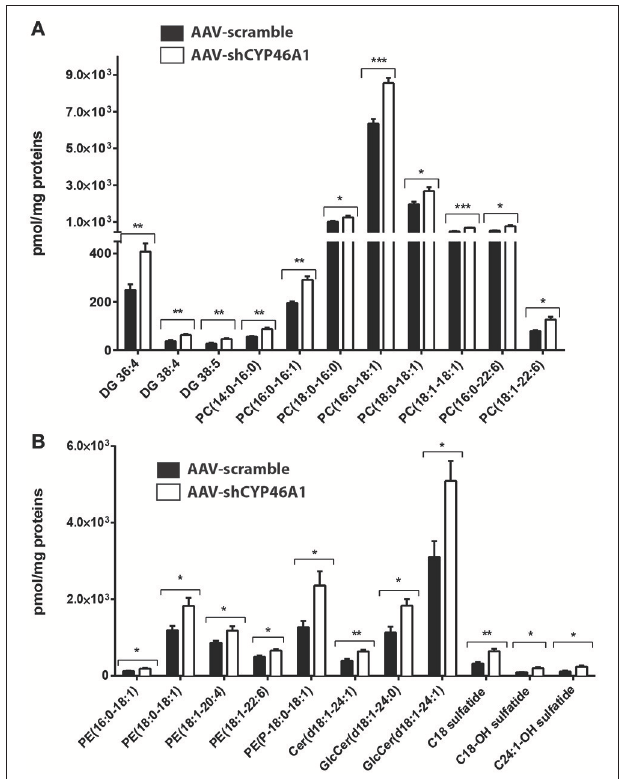
FIGURE 3 | Relative quantification of lipids in hippocampus of C57Bl/6 mice after injection of AA V5-scramble (control) and AA V5-shCYP46A1. (A,B) Rise of phosphatidylcholine (PC), diacylglycerol (DAG), ceramides (Cer), sulfatide, phosphatidylethanolamine plasmalogen (PE-P) and phosphatidylethanolamine (PE) in AAV-shCYP46A1 hippocampus compared to the control. The results are expressed as nmol per mg of proteins and as the mean ± SD ( n = 5 mice per group). Measurements were performed in triplicate. Unpaired t -test was performed. * P < 0.05, ** P < 0.01, and *** P <